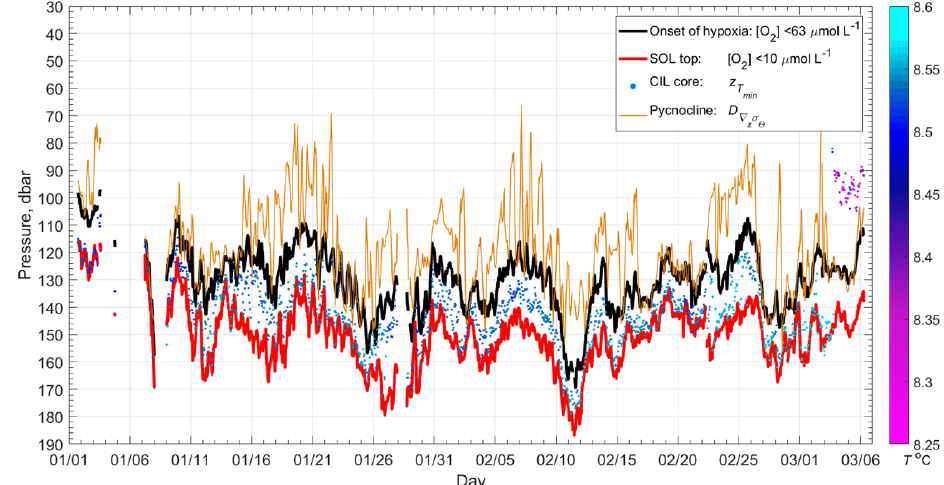
Figure 9. Depths of the hypoxia onset, suboxic layer, and maximum vertical gradient of density and the minimum water temperature (regarding the colored spots, refer to the color scale to the right of the figure).